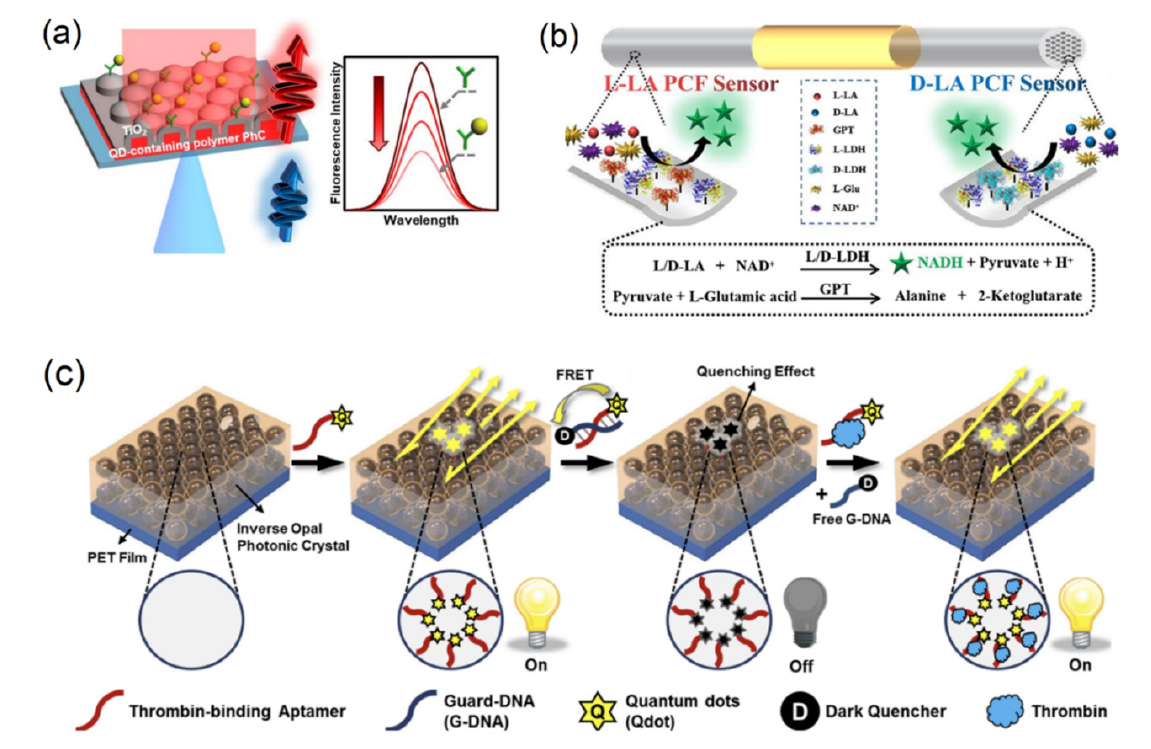
Figure 8. Embedded PC fluorescent biosensors. ( a ) Quantum dots encapsulated in a titanium dioxide PC for the detection of protein Troponin T, adapted with permission from [179]. ( b ) PC fiber for fluorescent detection of lactic acid enantiomers, adapted with permission from [133]. ( c ) Fluorescent aptamer detection of thrombin using a three-dimensional inverse opal PC, adapted with permission from [180].